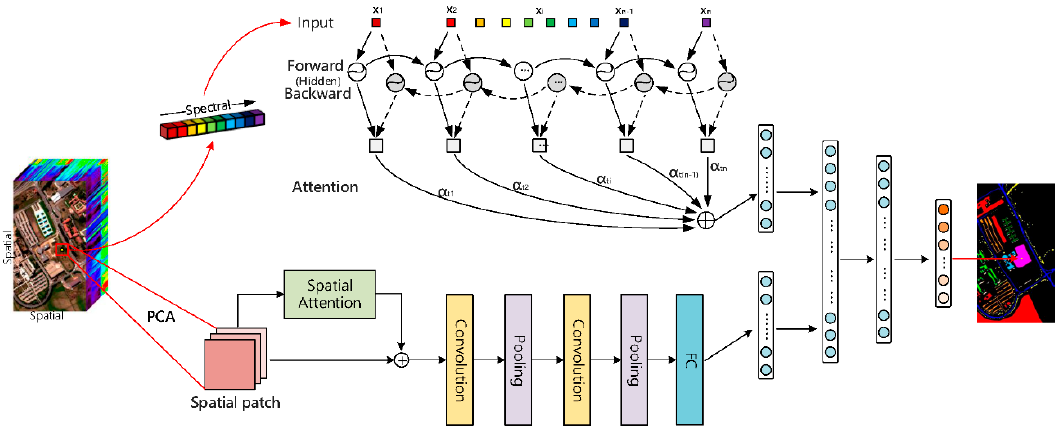
Figure 5. An example of adding attention networks (i.e., spatial and channel attentions) to a RNN + CNN module for hyperspectral image classification [79]. PCA—principal component analysis.